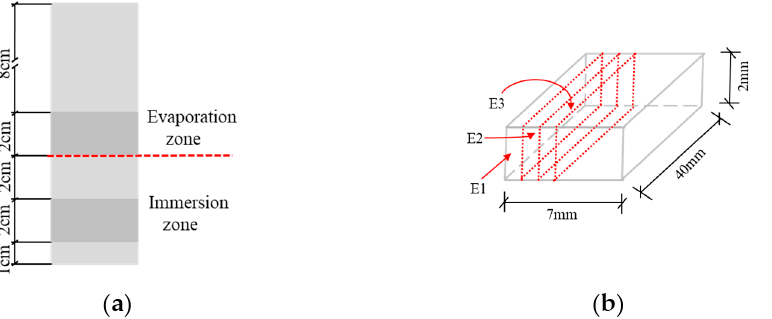
Figure 2. Sampling method of the specimen. ( a ) Different zones of the specimen. ( b ) Sampling in evaporation zone.